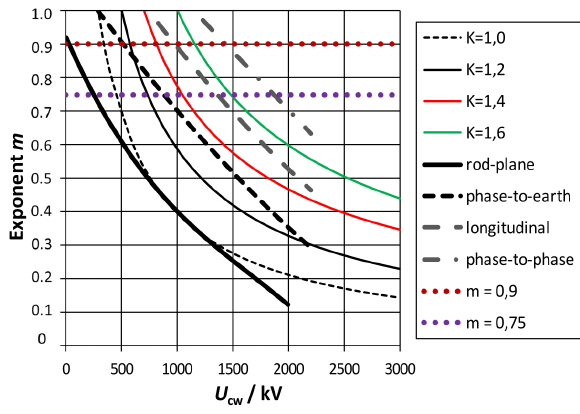
Figure A1. Functions m ( U cw ) of [2] in comparison to their re-determined counterparts of [17]. Figure reproduced with permission from K YNAST , [17]; published by VDE-Verlag,